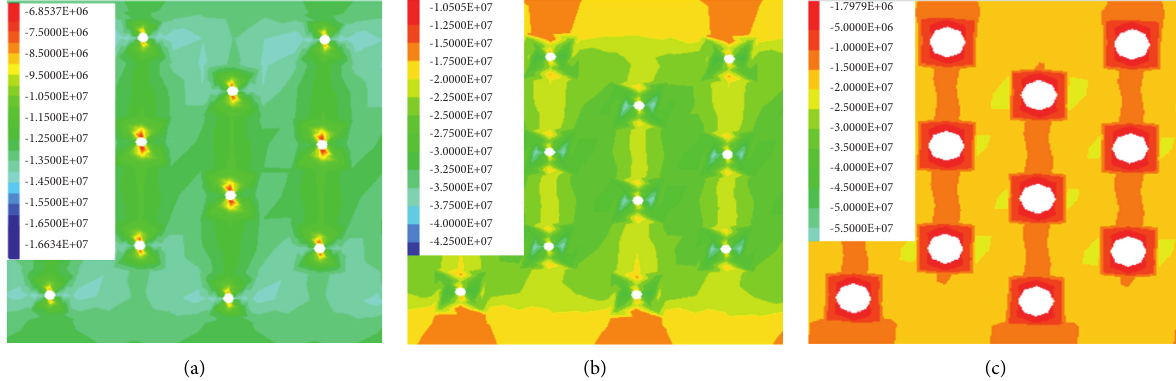
Figure 7: Vertical stress distribution of nonequal diameter pressure relief hole a different depths along the axis. (a) 2 m from the coal rib. (b) 4 m from the coal rib. (c) 6 m from the coal